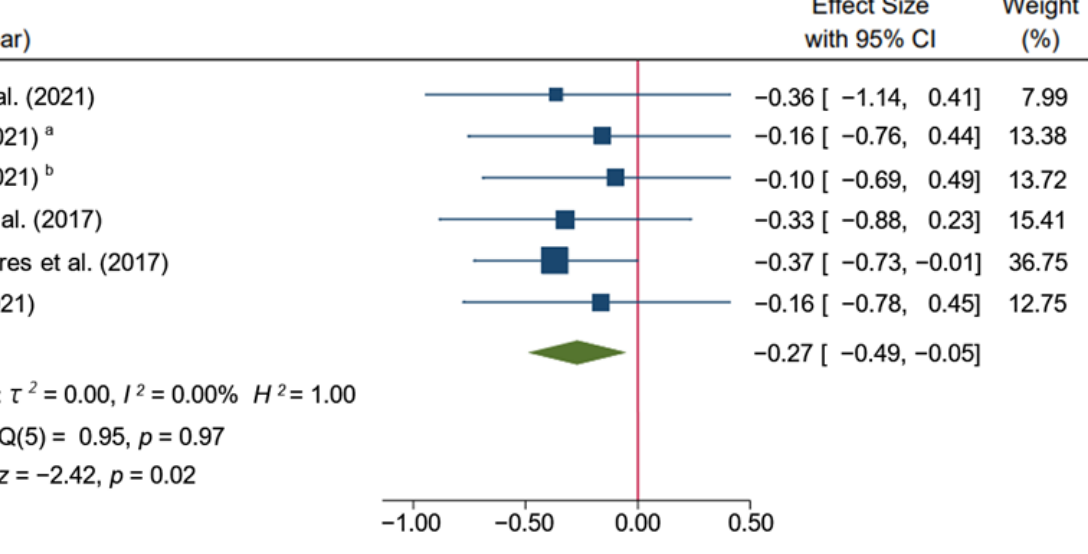
Figure 4. Forest plot of comparison in the short-term: Dry Needling group alone or combined with